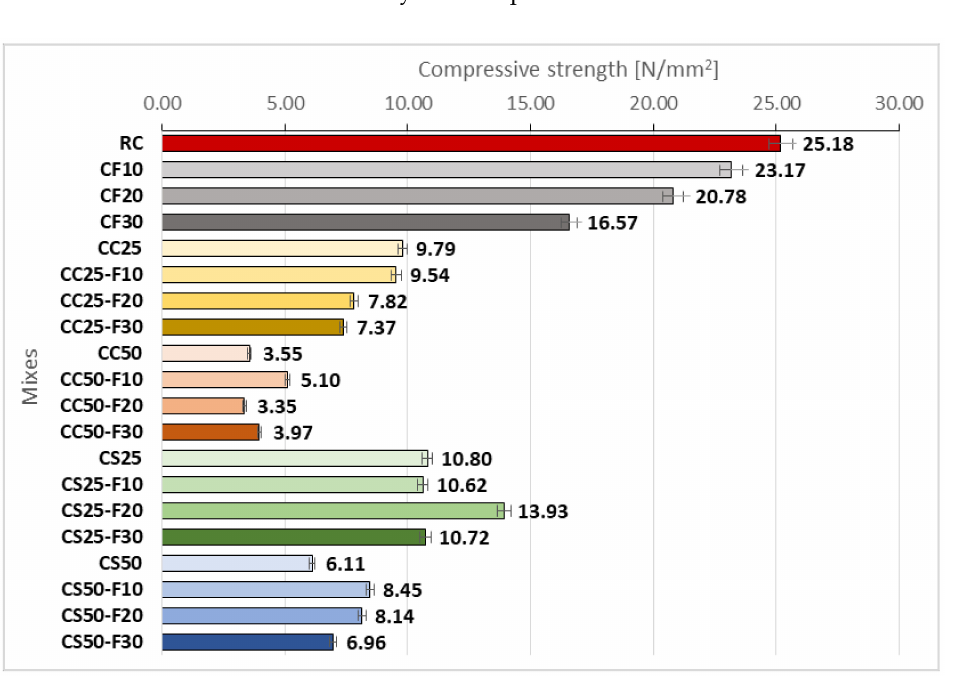
Figure 14. Compressive strength of the cement-based composites [N/mm 2